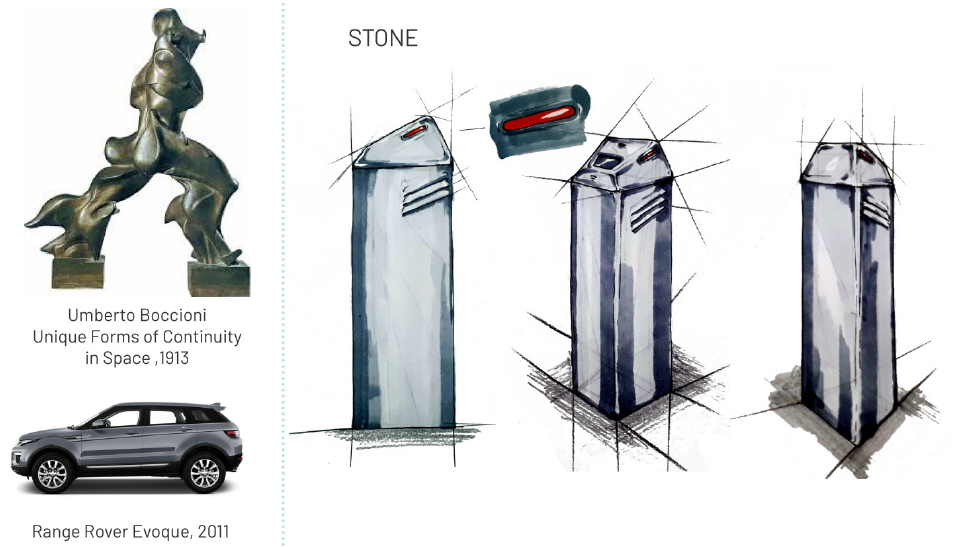
Figure 12. Stone style.